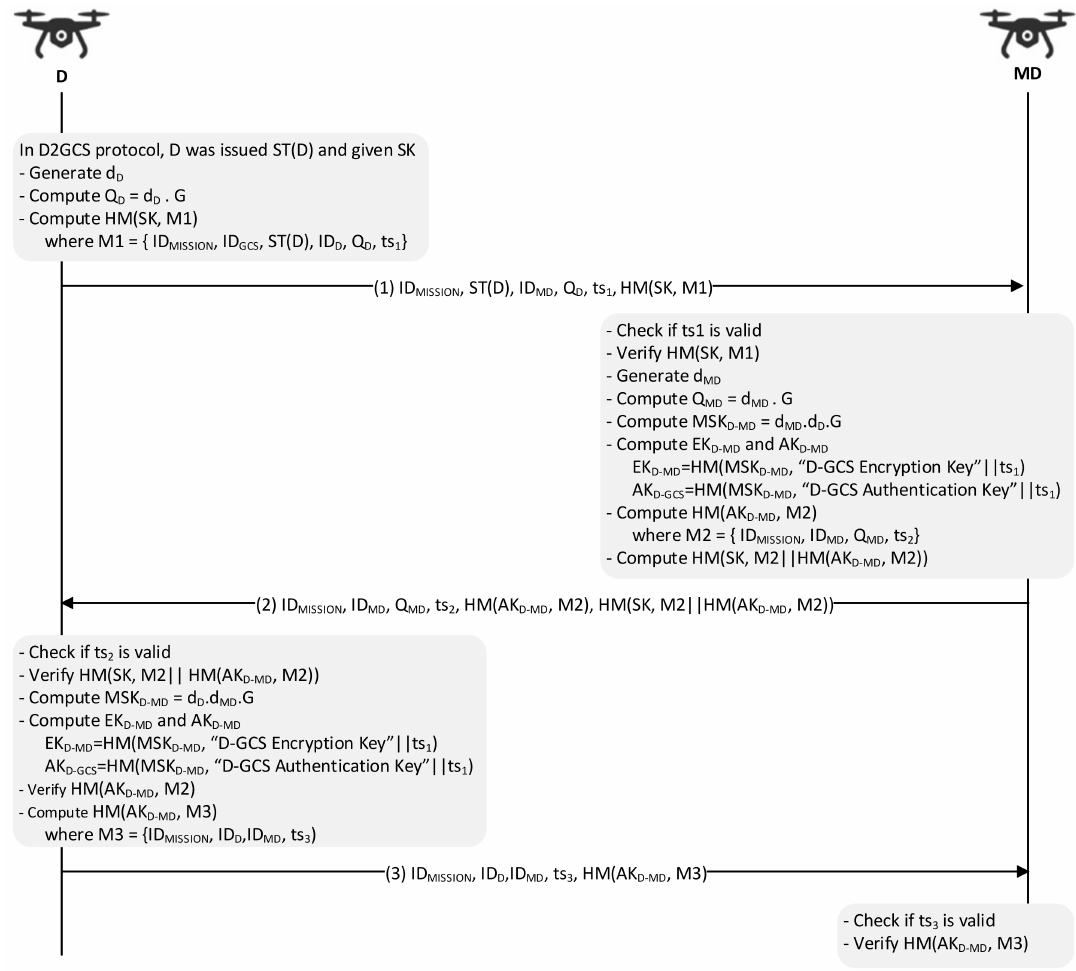
Figure 5. SP-D2MD